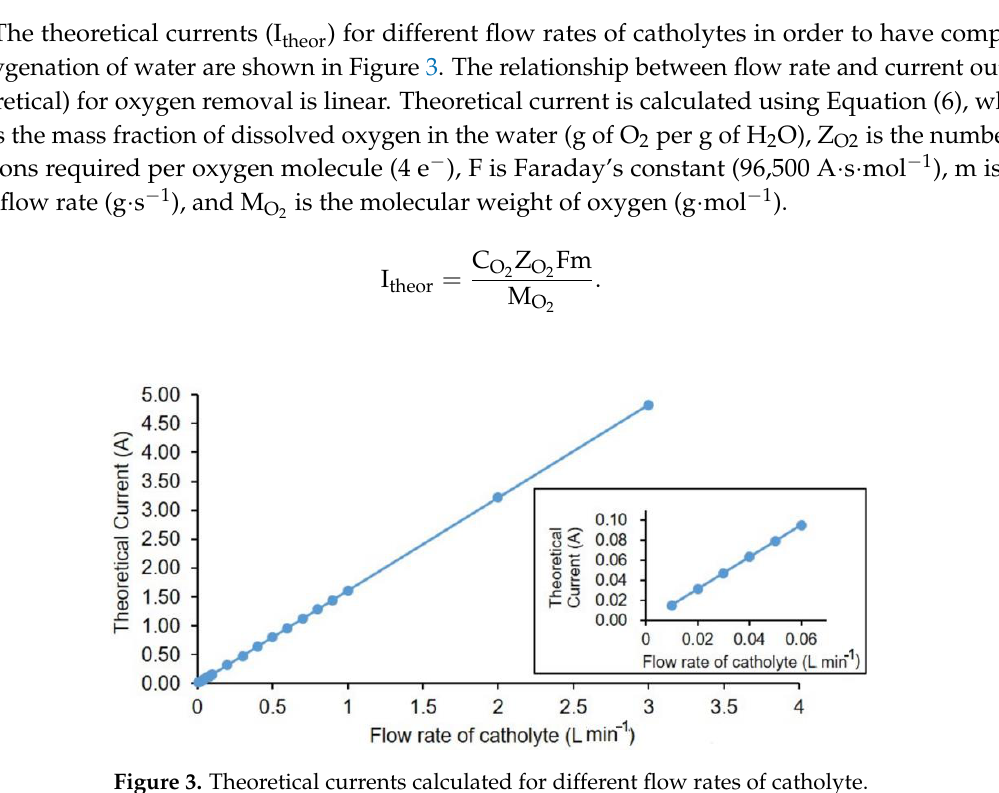
Figure 3. Theoretical currents calculated for different flow rates of catholyte.